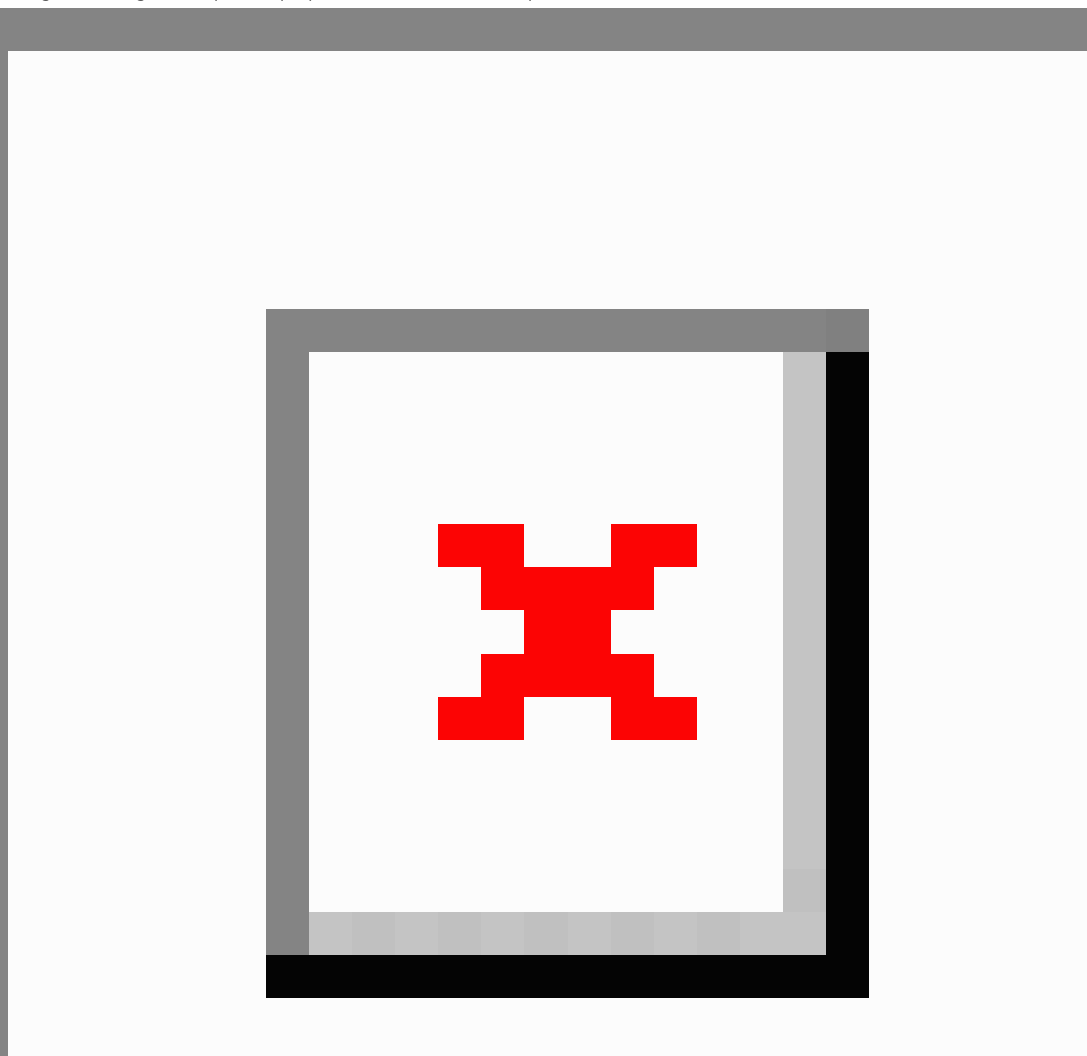
Figure 8. Radar chart showing feature means (overall users within a cluster) of the contribution behavior clusters. The means are min-max-normalized to a [0;1] range. The length of a spoke is proportional to the value it